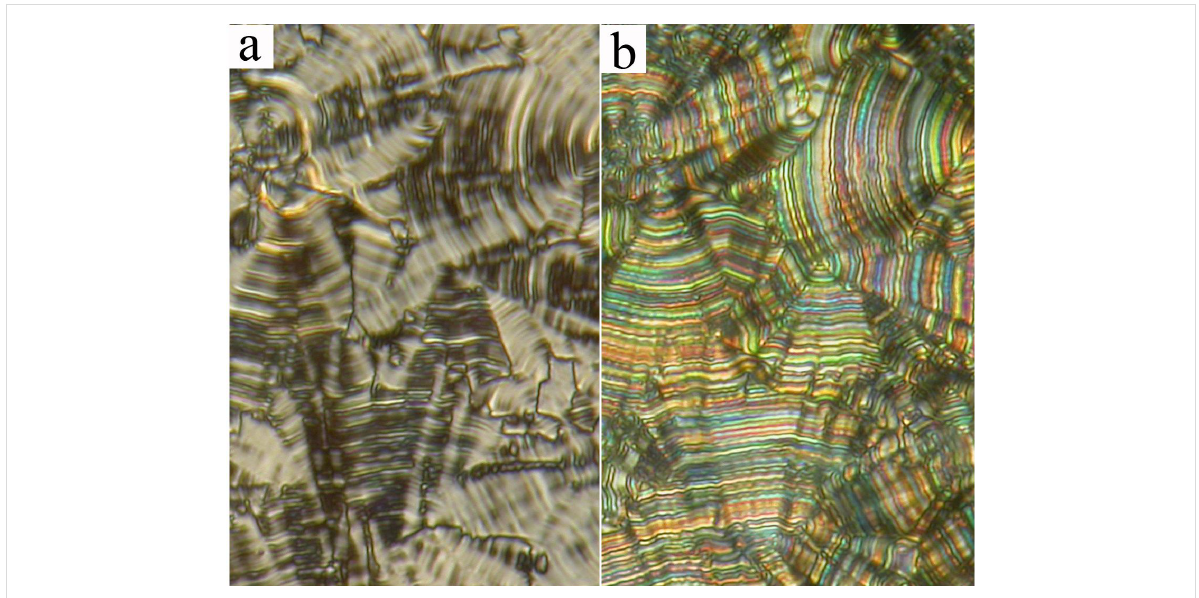
Figure 4: Planar texture of Ib in the SmC A P A phase at temperature T = 130 °C (a) without field, and (b) in the applied electric field 25 V/ μ m, when the system turns to the SmC S P A phase. The width of the microphotograph is 250 μ m.